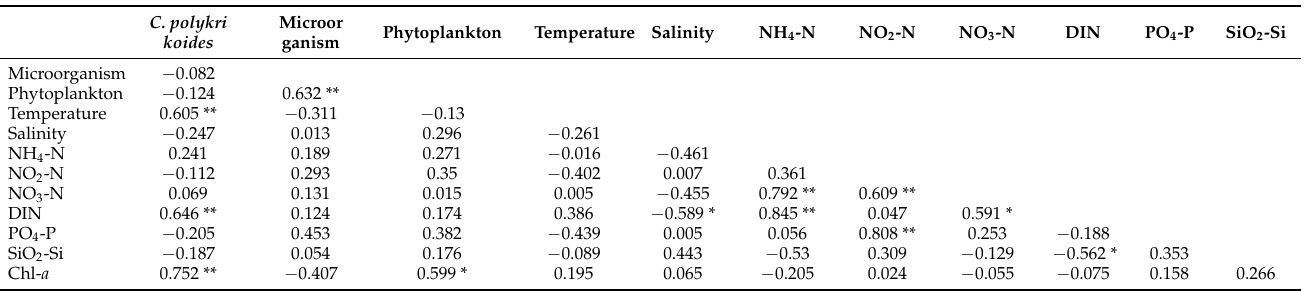
Table 4. Pearson correlation coefficient between environmental variables and C. polykrikoides rDNA copies (* p < 0.05; ** p <